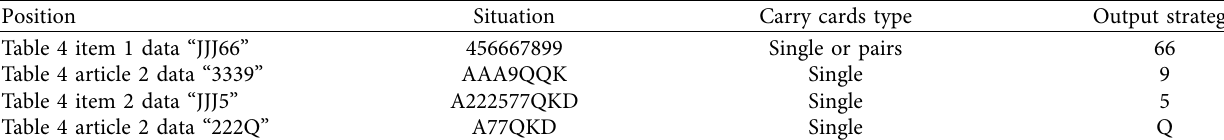
Table 4: Carrying card strategy.